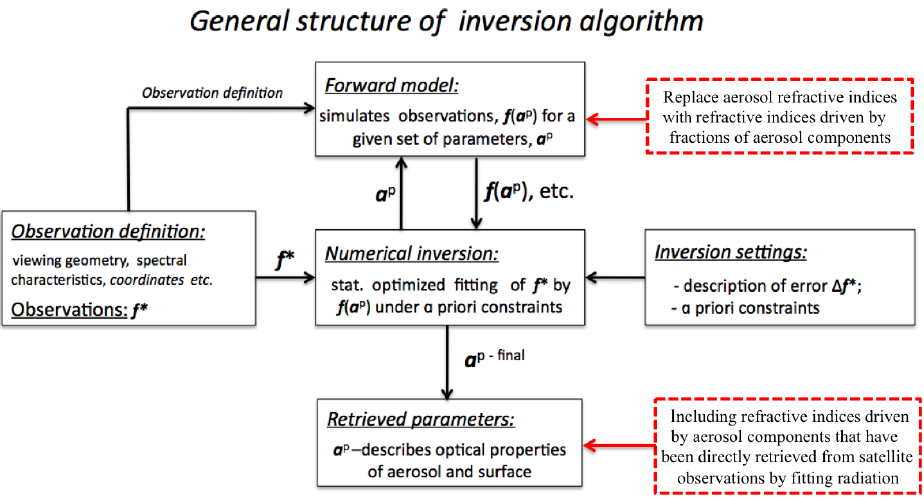
Figure 1. The general structure of the GRASP algorithm with the aerosol component conversion model, courtesy of Dubovik et al. (2011). The red dashed frames represent modifications for the component inversion approach. f ∗ represents a vector of inverted measurements, a P represents a vector of unknowns at the p th iteration, and f ( a P ) represents a vector of measurement fit at the p th